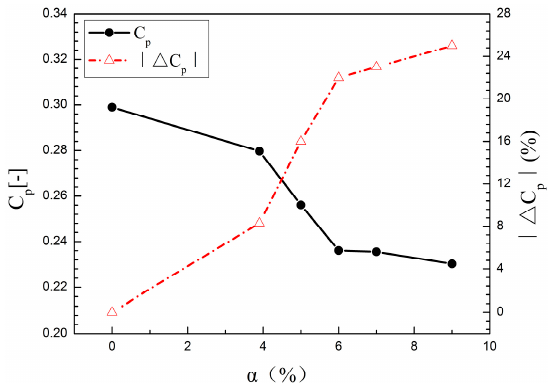
Figure 9. Power coefficient and its relative change with respect to α = 0 in one turbine revolution.